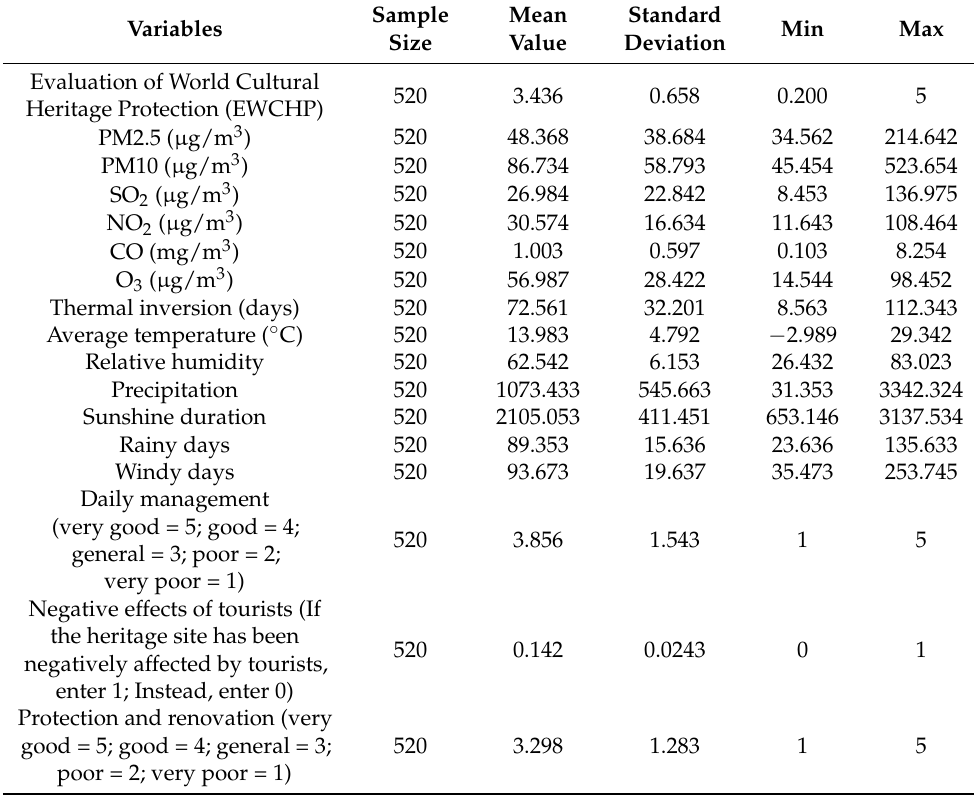
Table 1. Descriptive statistics of